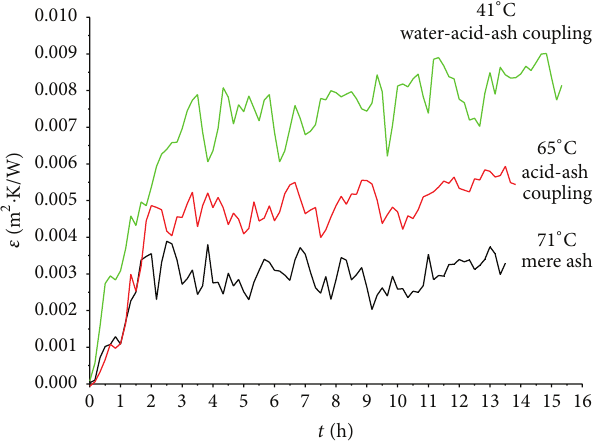
Figure 9: Real-time curve of 𝜀 under typical temperature of outer wall.